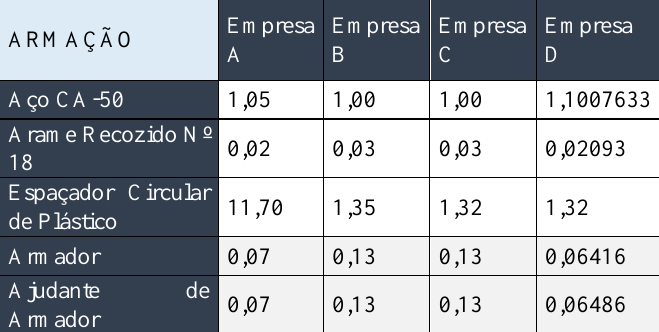
Tabela 2: Índices do serviço de armação